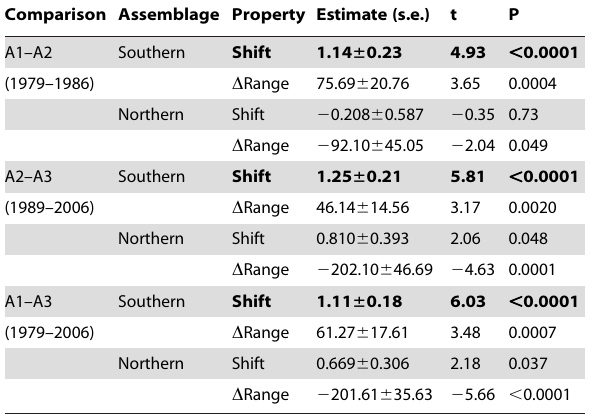
Table 2. Analyses of the shift in range margin (in km/year) of 114 European birds with their northernmost distributional margin in southern Finland (‘southern’ species) and 34 northern breeding species with their southernmost distributional margin in northern